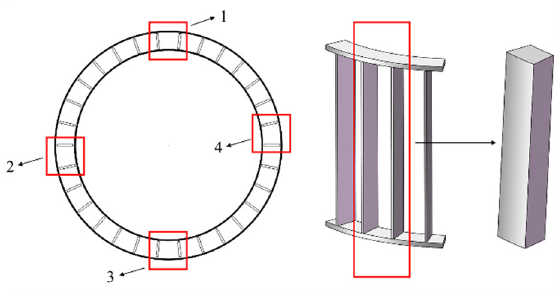
Figure 6. Location of the sampling points.